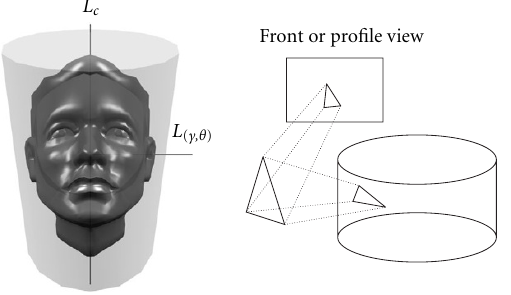
Figure 5: Projecting the 3D model triangles on the cylindrical sur- face in order to generate the texture